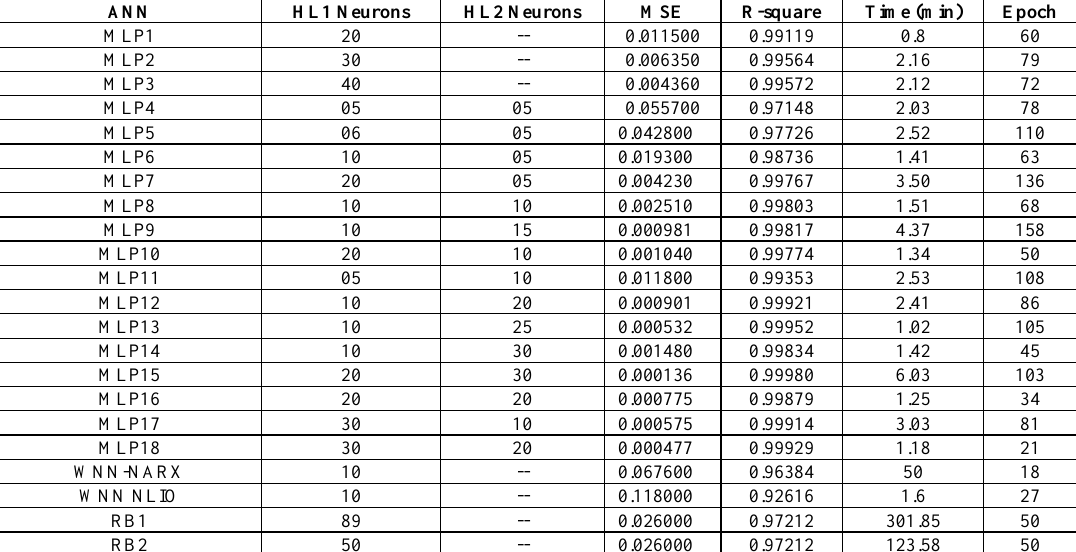
Table 2. Iteration of MLP with different neurons